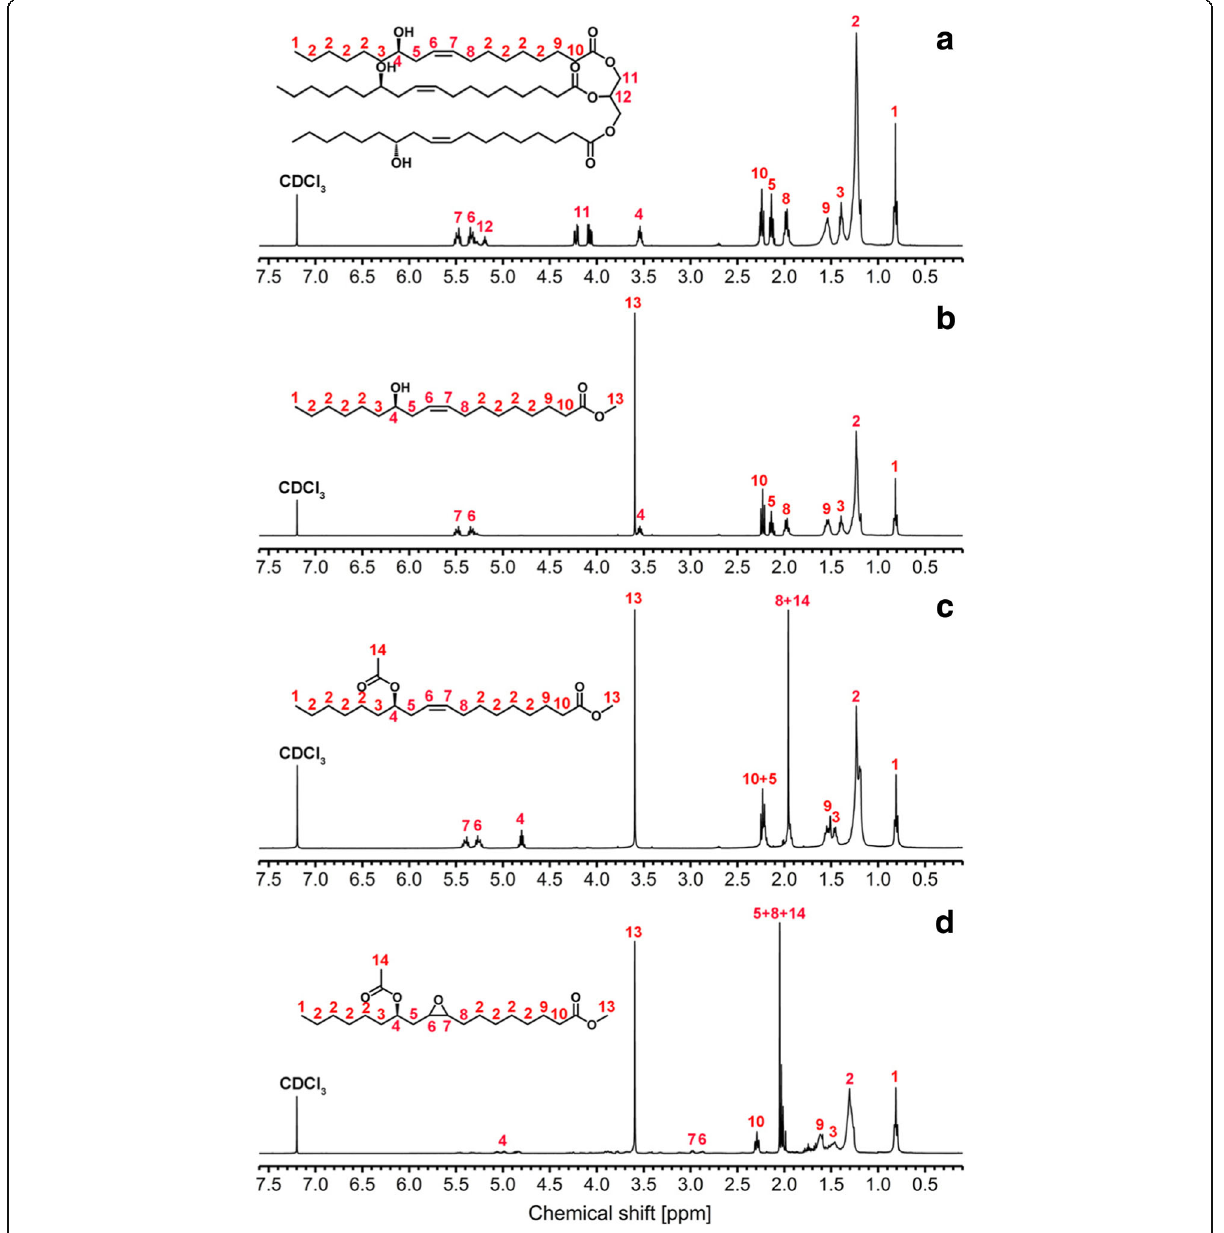
Fig. 2 1 H NMR spectra of a CO, b MR, c MRA, and d